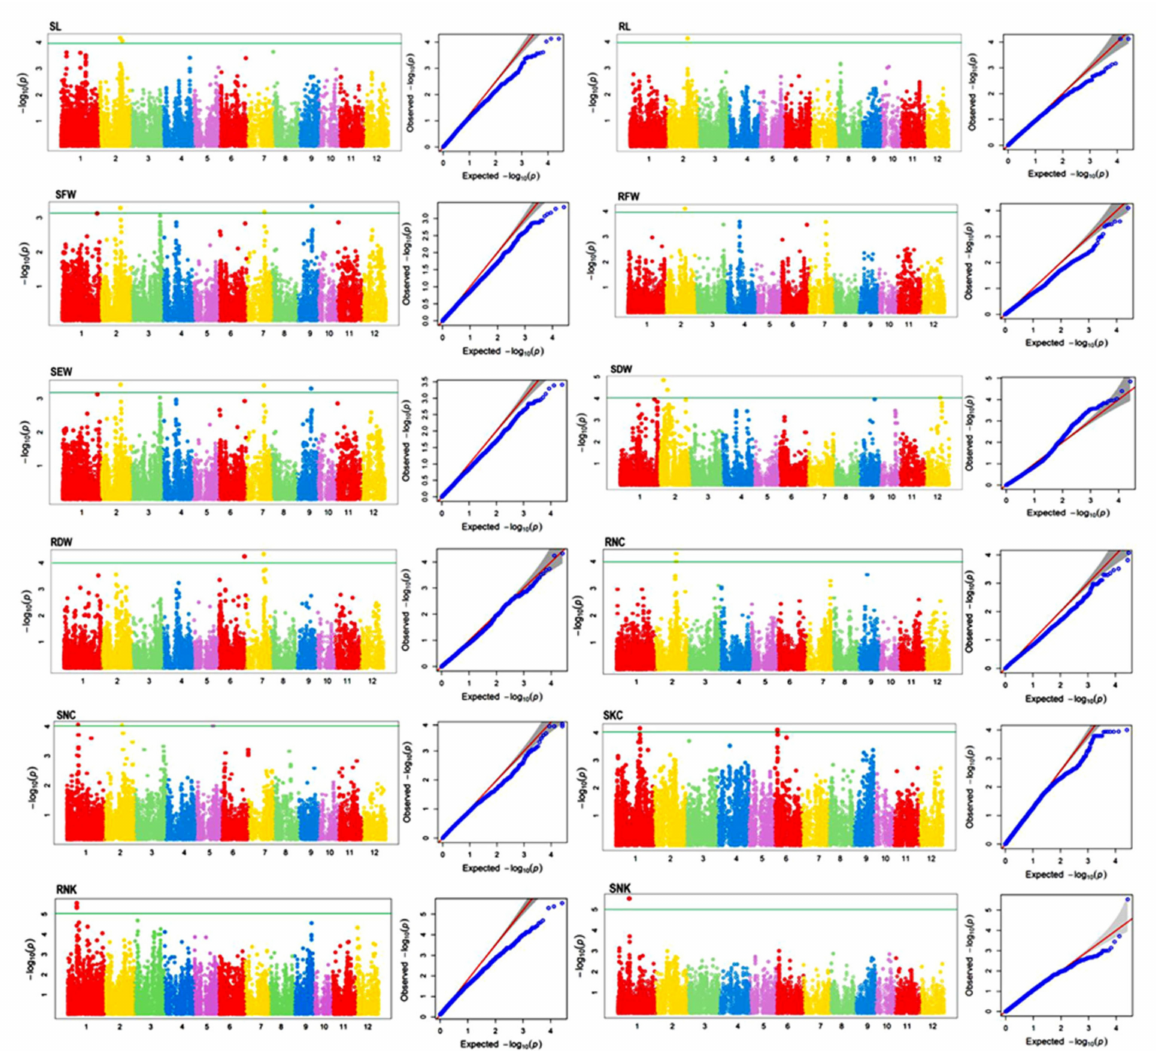
Figure 5. Manhattan plots and Q–Q plots representing the significant marker trait associations for 12 seedling salt tolerance related traits. SL, shoot length (cm); RL, root length (cm); SFW, shoot fresh weight (g); RFW, root fresh weight (g); SEW,